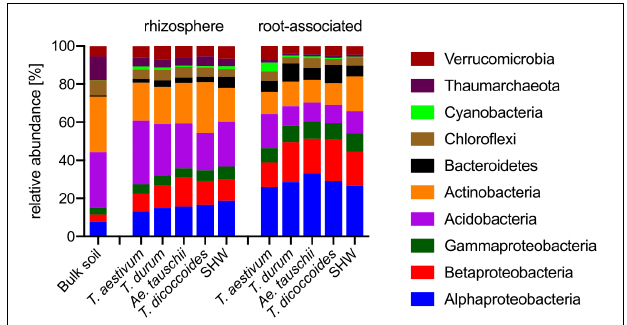
FIGURE 4 | Phylogenetic annotation of rhizosphere and root-associated OTUs found for each wheat species. Bars represent averaged relative abundance of each phyla for each wheat species. bulk soil n = 8, rhizosphere n = 24, 23, 18, 20, 24, root n = 23, 16, 15, 18, 23 biological replicates for each